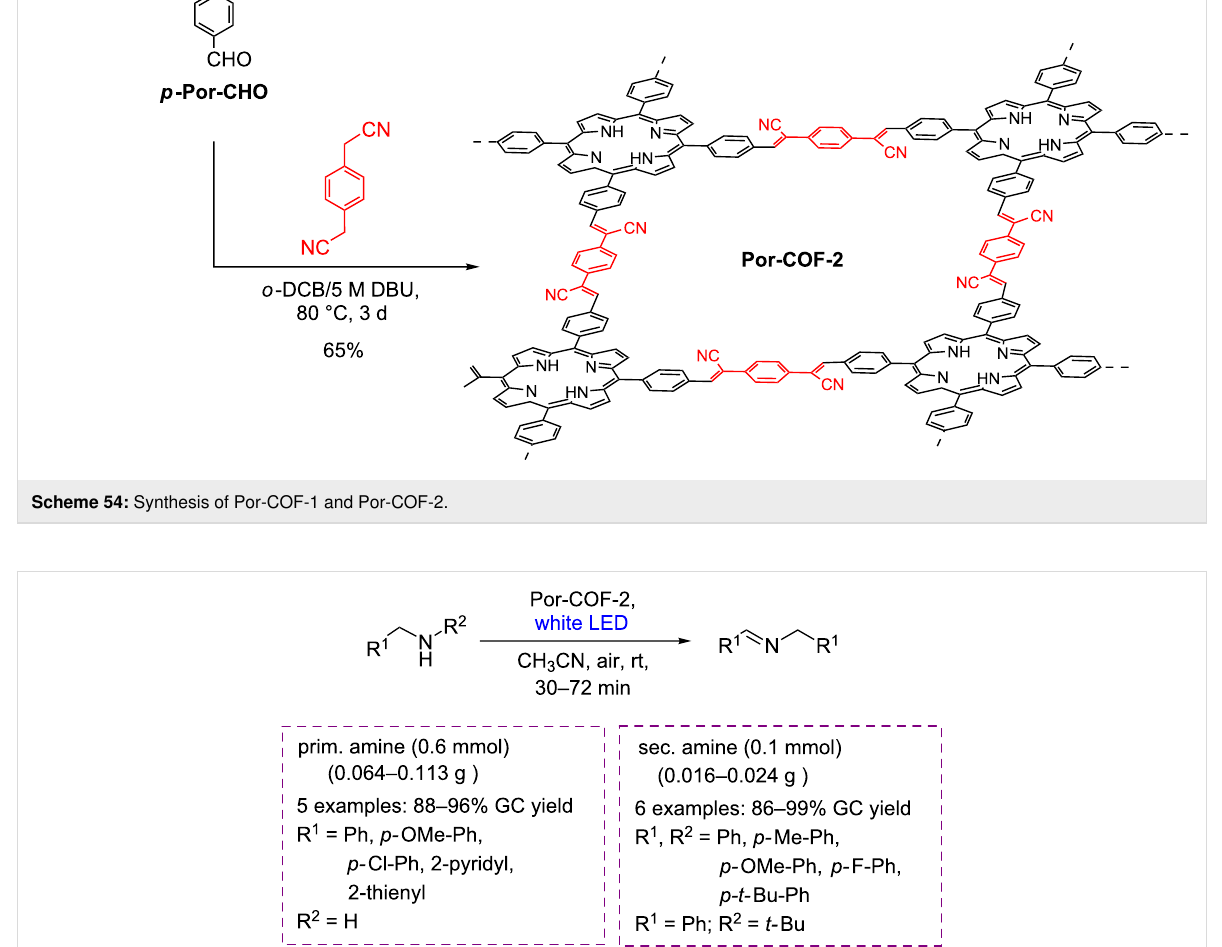
Scheme 55: Photocatalytic oxidation of amines to imines by Por-COF-2.